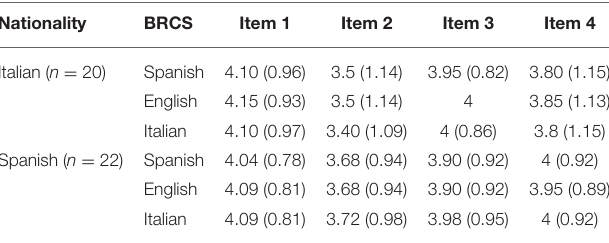
Correlation across items for the Italian version in Italian participants ranged from 0.604 to 0.831, and for the Spanish participants from 0.617 to 0.826. Correlation across items for the Spanish version in Italian participants ranged from 0.491 to 0.769, and for the Spanish participants from 0.679 to 0.784. Correlation across items for the English version, and original one, in Italian participants ranged from 0.526 to 0.815, and for the Spanish participants from 0.682 to